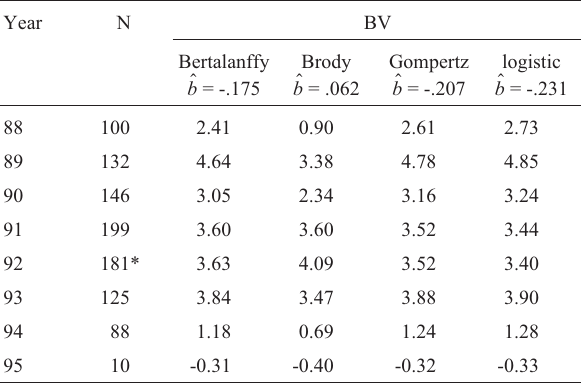
(cid:2) b )forasymptoticweightinthefourmodelsstud-